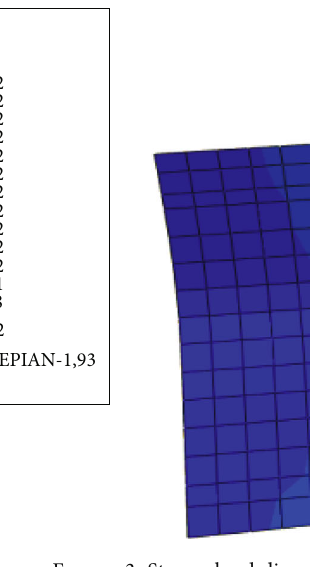
Figure 3: Stress cloud diagram of blade (maximum-continuous working state).